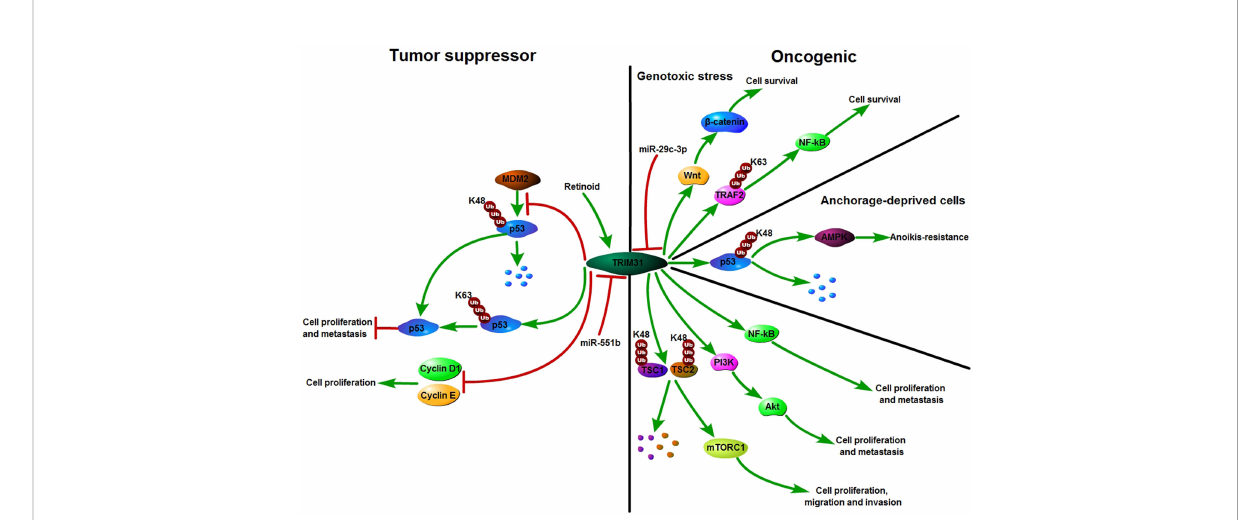
FIGURE 3 Schematic diagram of TRIM31 function in cancer. TRIM31 can act as either a tumor suppressor or an oncogene. TRIM31 inhibits cell growth by reducing the expression of Cyclin D1 and Cyclin E. TRIM31 stabilizes P53 expression to suppress tumor cell proliferation and metastasis. TRIM31 promotes tumor onset and progression by regulating the P53, mTORC1, PI3K-Akt, NF-kB and Wnt/ b -catenin pathways. Retinoid induced cell growth arrest by targeting the promoter of TRIM31. miR-551b suppresses the expression of TRIM31 by targeting its 3 ’ -UTR and further promotes cell invasion and drug resistance. miR-29c-3p can inhibit TRIM31 expression by targeting its 3 ’ -UTR. TRIM31 activated Wnt/ b -catenin signaling to promote cell